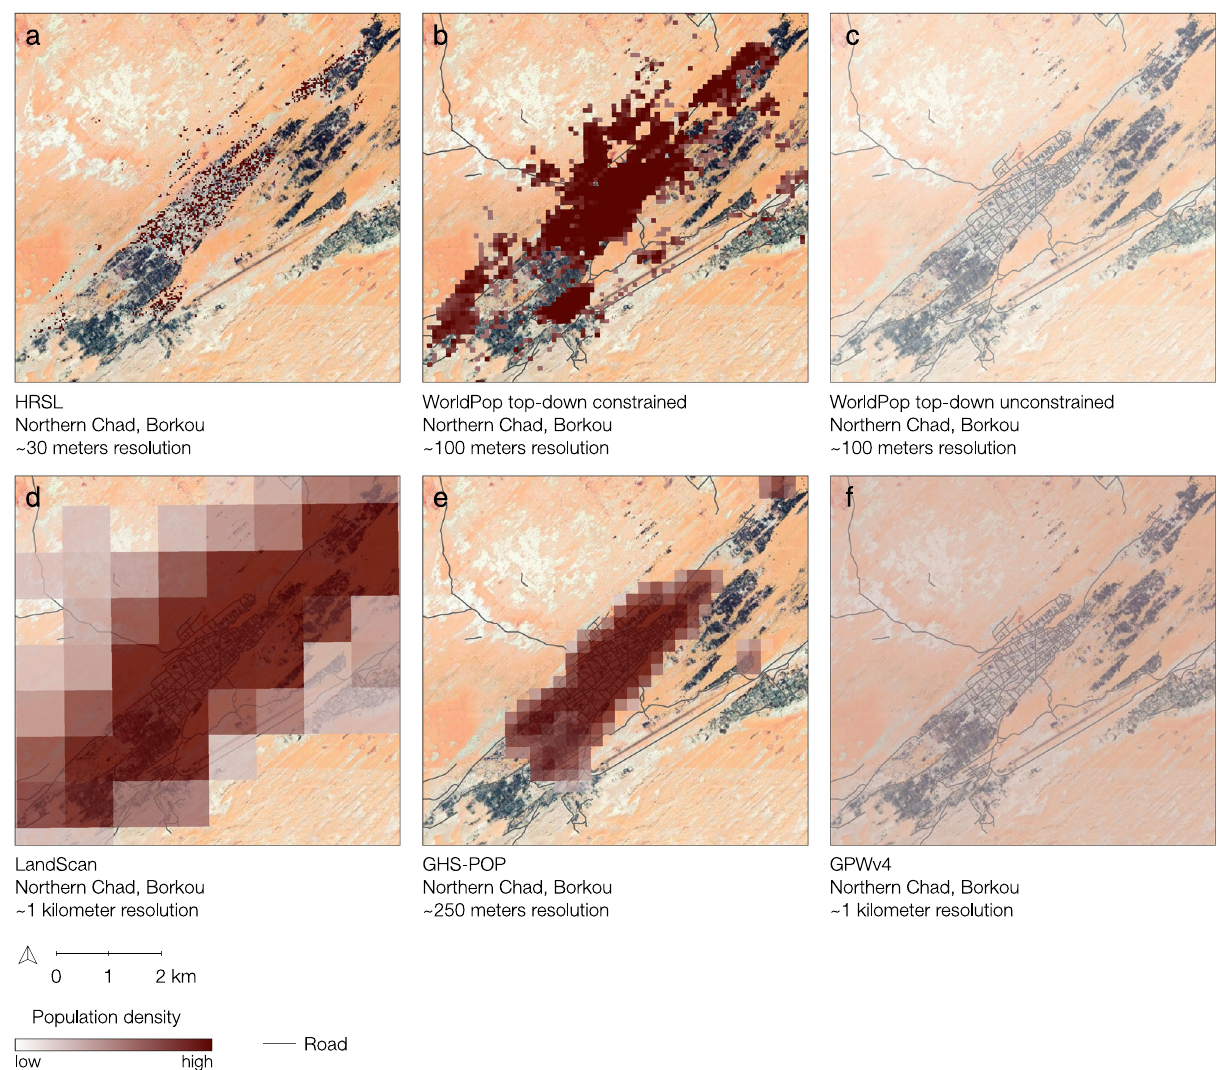
Fig. 6 Visual comparison of gridded population datasets. Visual differences between a HRSL, b WorldPop top – down constrained, c WorldPop top – down unconstrained, d LandScan, e GHS-POP, and f GPWv4 for Borkou, a northern region in Chad. Google satellite imagery as background (Map data© 2015 Google). White transparent color represents low numbers of population